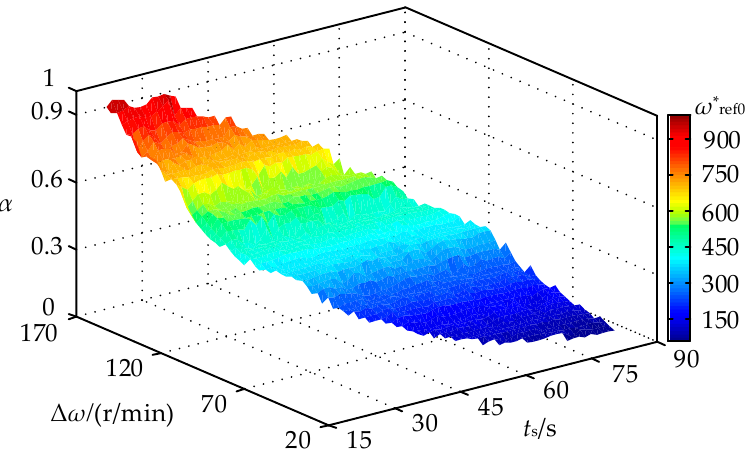
Figure 5. The effect of α on synchronization error and the adjusting time.